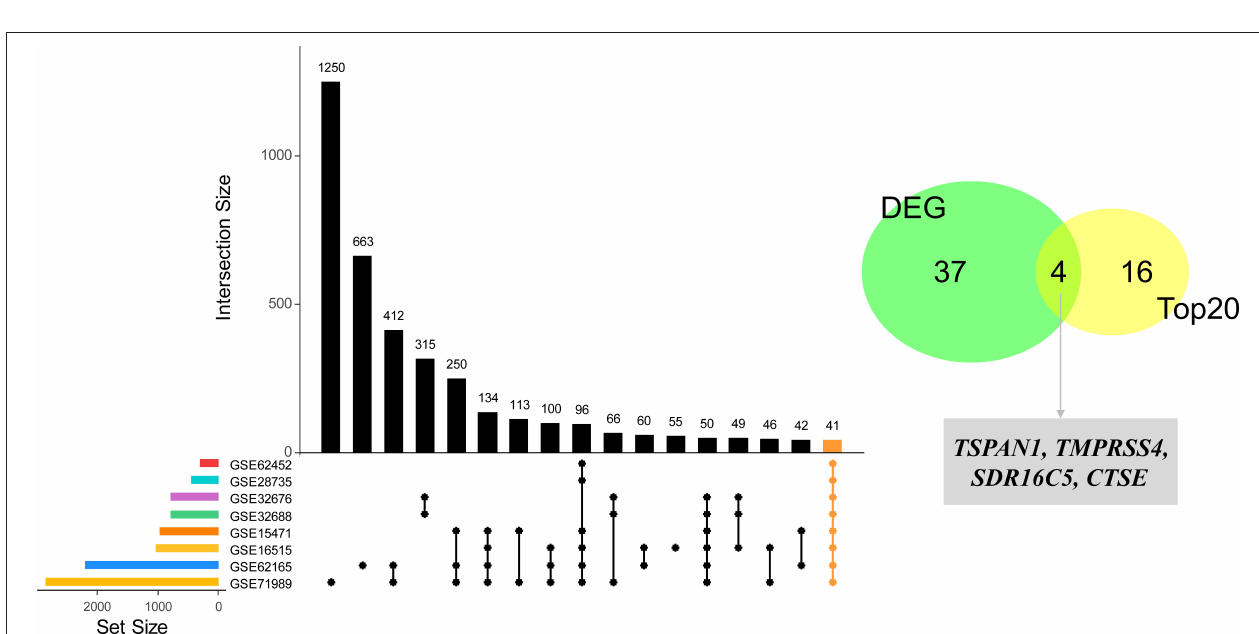
FIGURE 5 | Identification of four hub genes by eight datasets validation. Forty-one DEGs were identified through the intersection of the DEGs of 8 GEO datasets (GSE15471, GSE28735, GSE62165, GSE32688, GSE71989, GSE62452, GSE62165, and GSE32676), and then four hub genes were identified by an intersection with the top 20